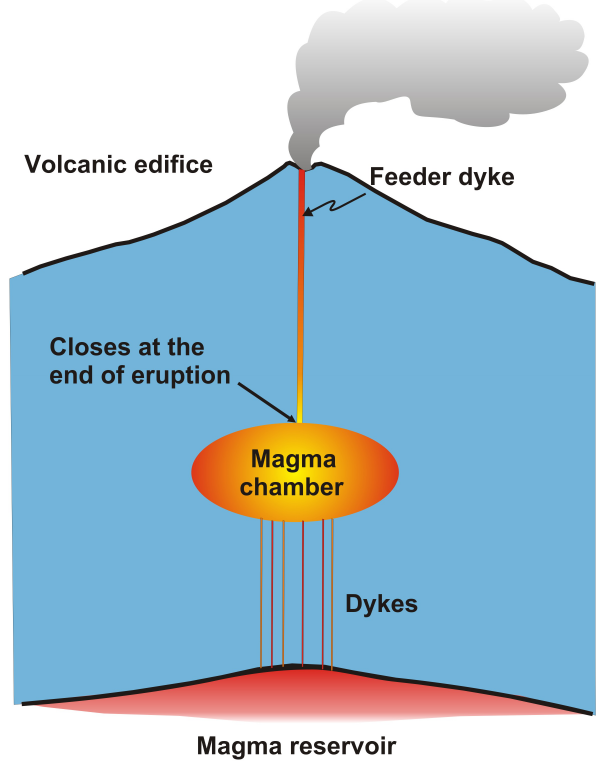
Fig. 10. Schematic illustration of a feeder dyke extending from a crustal magma chamber to the surface of a volcanic edifice. The crustal magma chamber, in turn, is supplied with magma from a deeper magma reservoir, in the lower crust or at the top of the man- tle. For a basaltic feeder dyke, the bottom of the dyke closes when the excess pressure in the chamber is no longer able to hold the dyke-fracture open at its junction with the chamber. When this hap- pens, magma flow up the feeder dyke ceases and the eruption comes to an